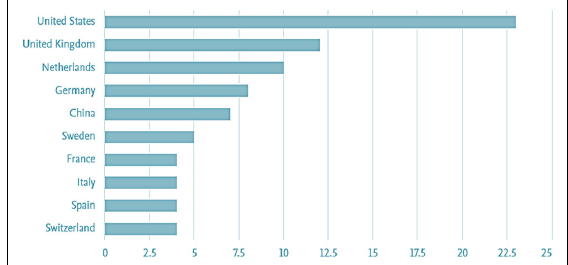
Fig. 3. The growth of the publication based on the variable "Artificial Leaf". Source: Scopus scientific review